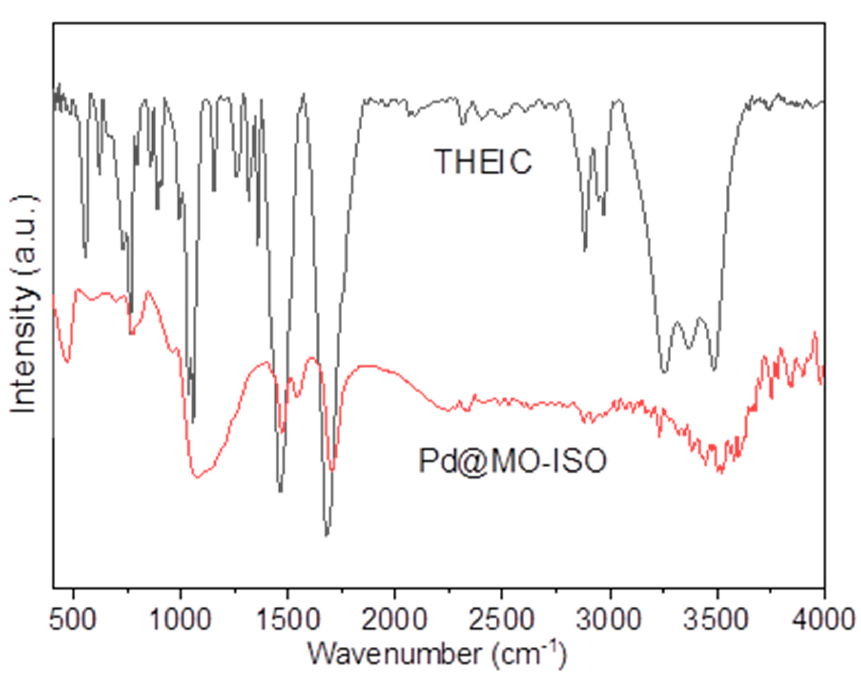
Figure 3. ATR-FTIR spectra of THEIC and Pd@MO-ISO.